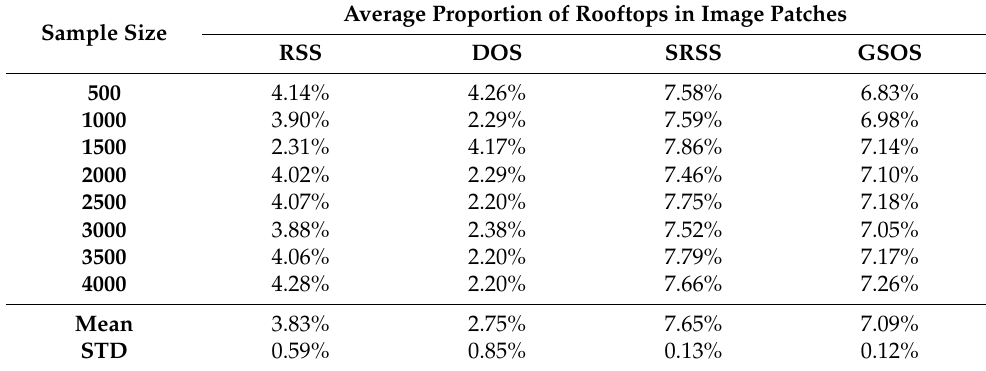
Table 2. Statistical comparison results of the rooftop proportion for different sampling strategies. Average Proportion of Rooftops in Image Sample Size